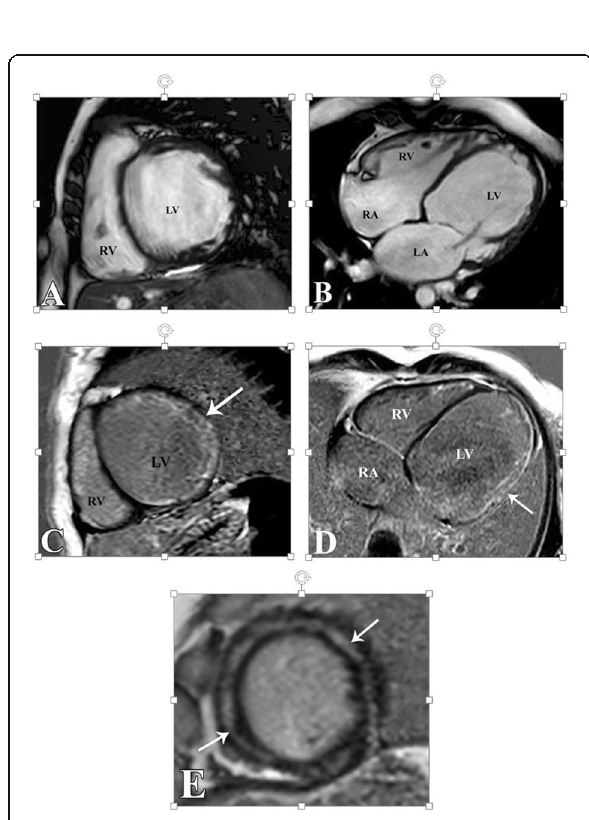
Fig. 3 Post myocarditis dilated cardiomyopathy. Sixteen-year-old female patient presented with signs of HF and history of myocarditis 1 year ago. Cine steady-state free precession (SSFP) in short axis ( a ) and four-chamber ( b ) views, shows marked dilated LV (EDV = 252 ml and ESV = 199 ml) and reduced EF (21%) that associated with thinning of the wall and global hypokinesia. Late gadolinium enhancement (PSIR) images in short axis ( c ) and four-chamber ( d ) view show diffuse transmural enhancement in mid, basal apical segments not following any vascular territory; also, there is diffuse sub-endocardial in basal segments seen in short-axis LGE image ( e